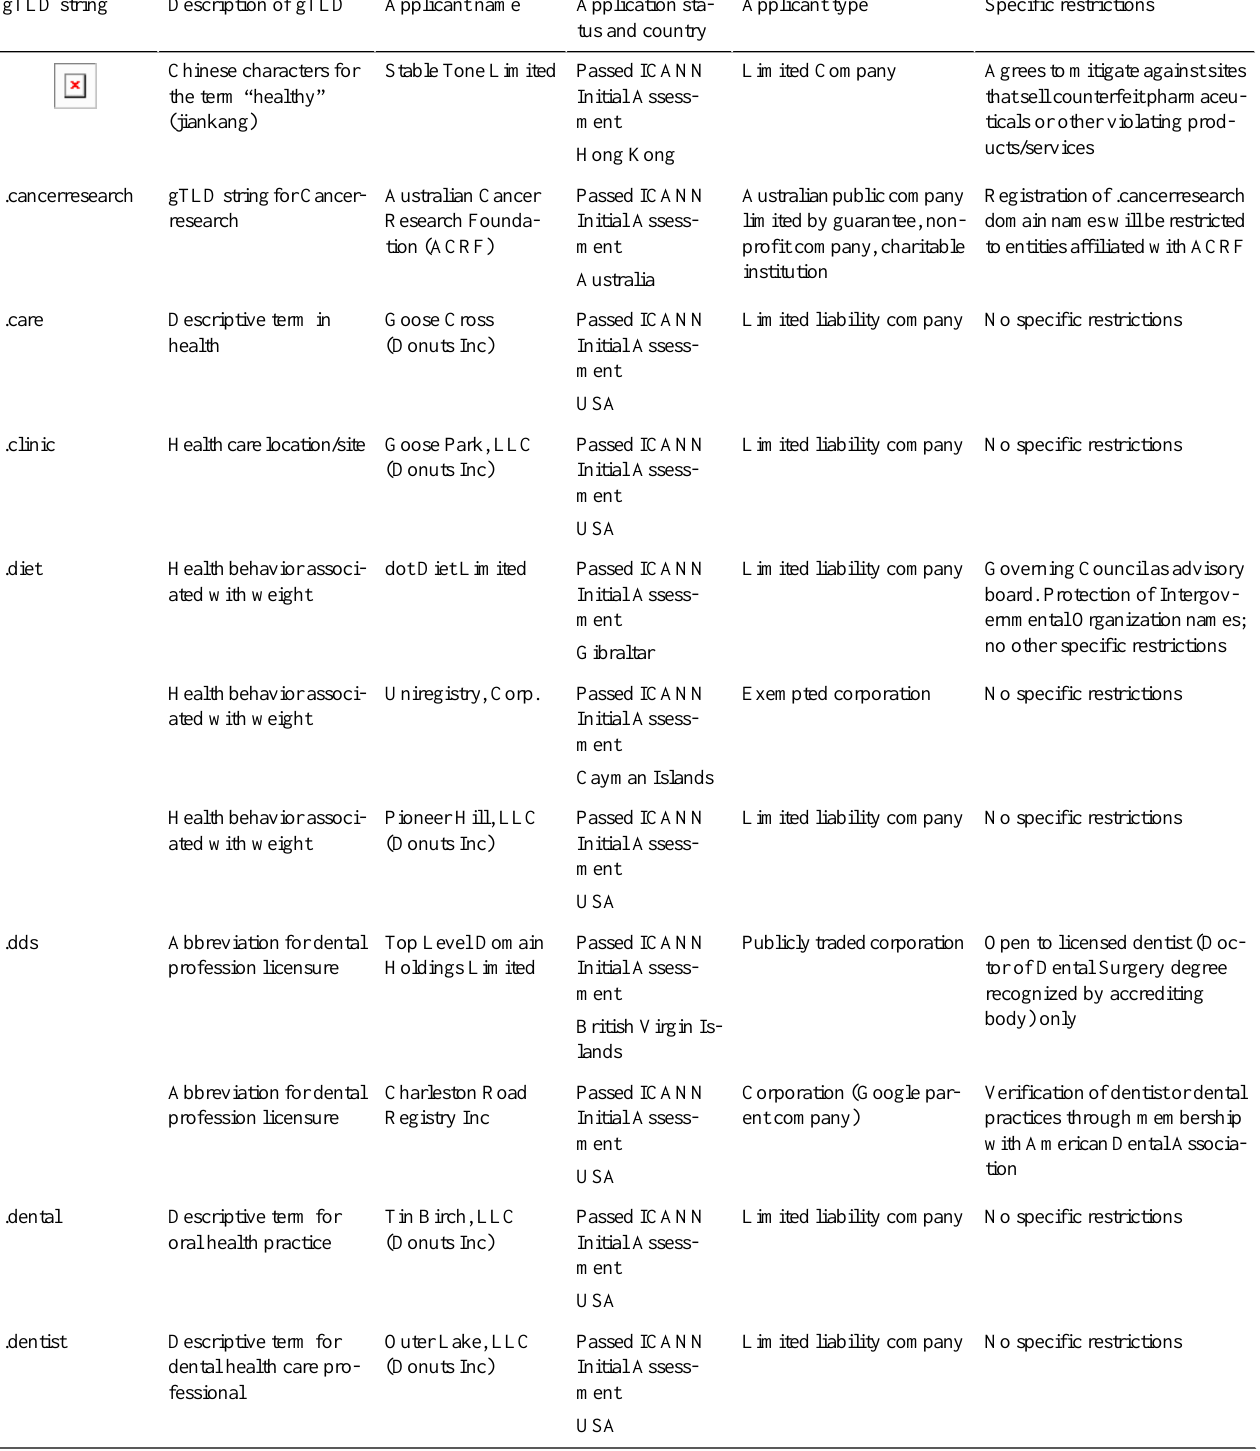
Table 3. Other health-related gTLD